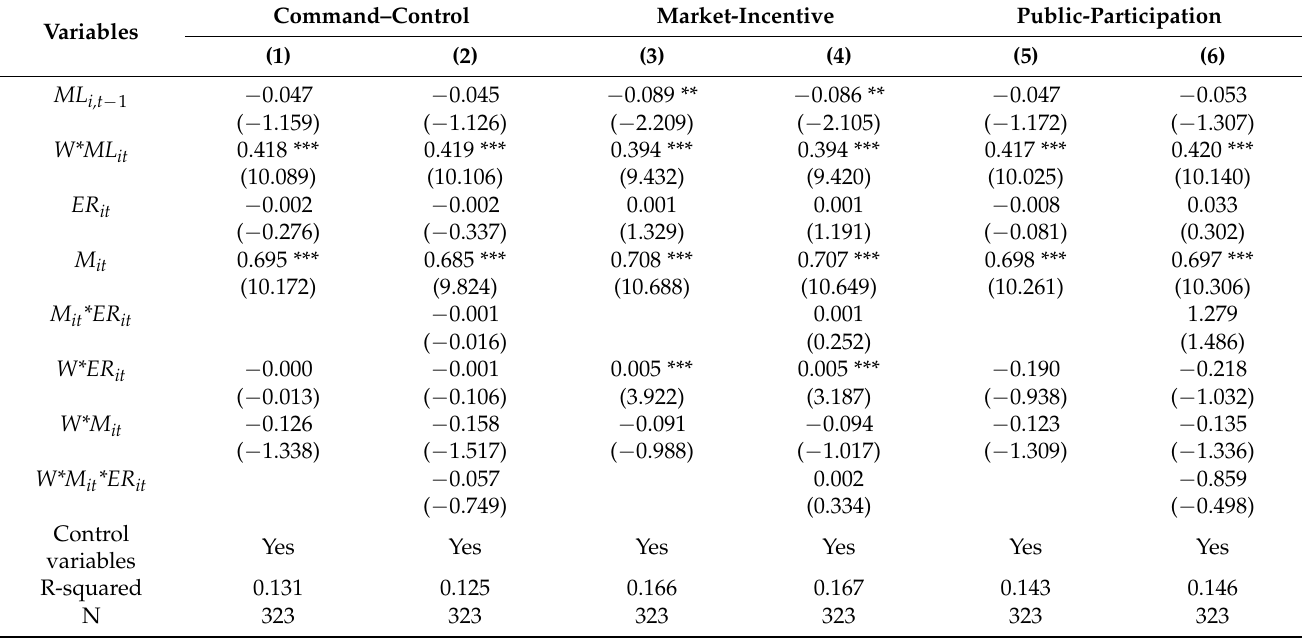
Table 11. The moderating results of efficiency change in the central and western